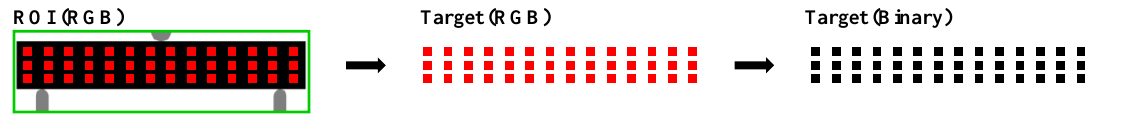
Figure 4. Target extraction procedure from ROI.